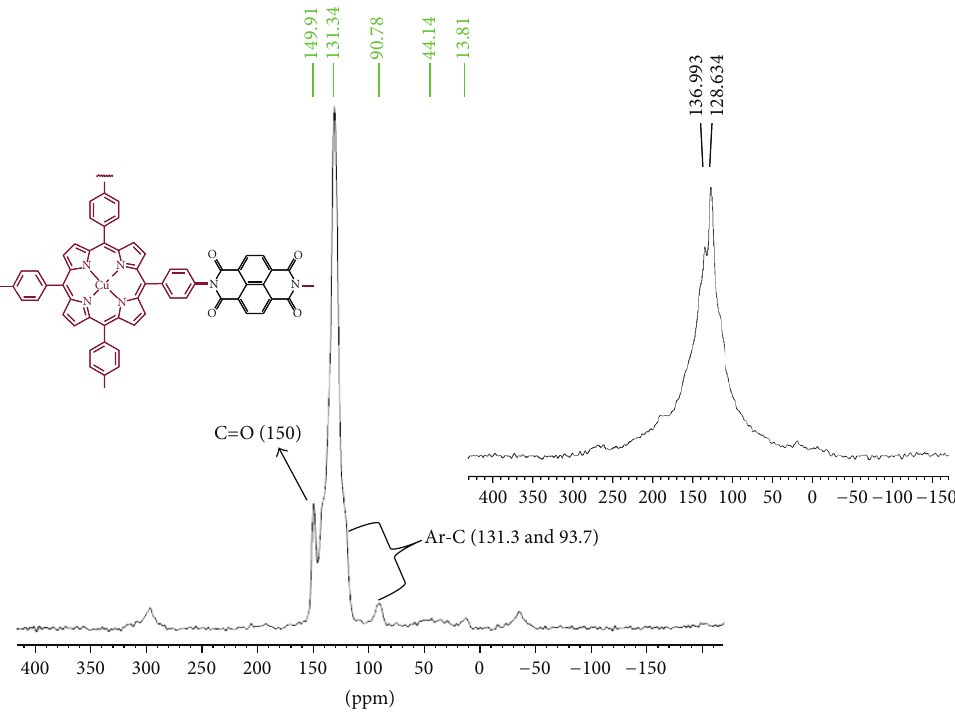
Figure 3: Solid-state 13 C CP-MAS NMR spectrum of PyP recorded at MAS rate of 10kHz.